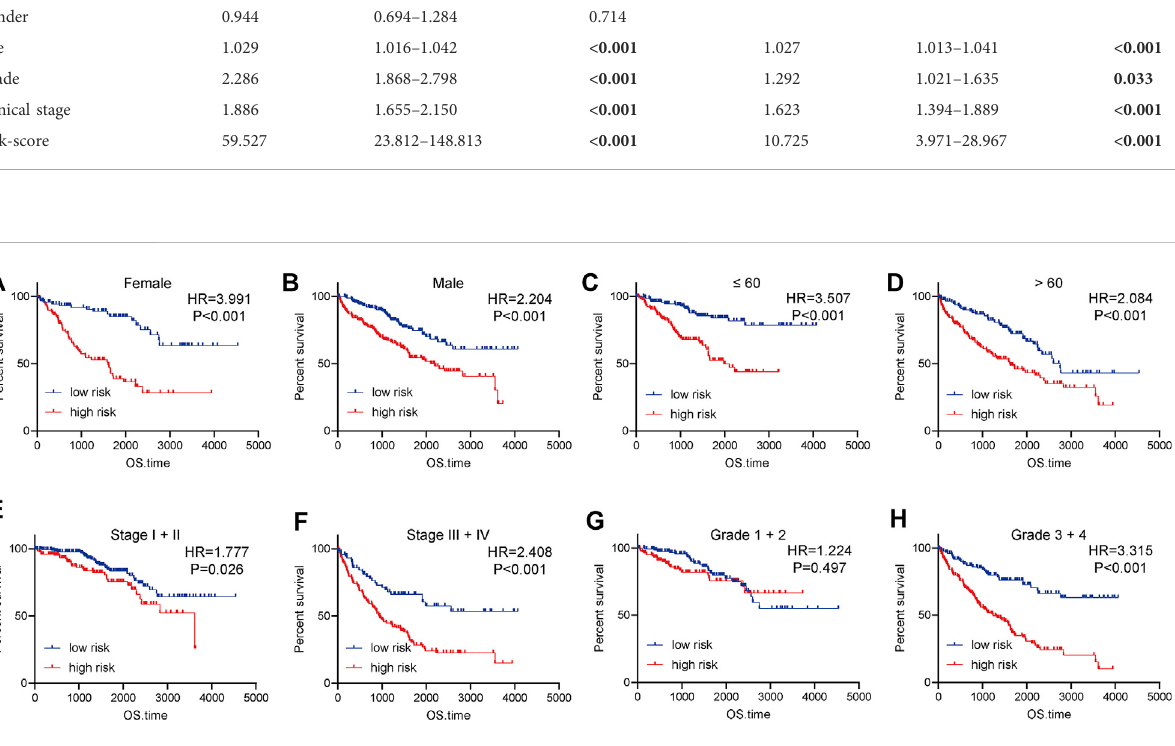
FIGURE 6 Subgroup analysis of the prognostic value of the risk score in ccRCC. (A,B) The prognostic value of the risk score in female and male patients. (C,D) The prognostic value of the risk score in patients with different ages. (E,F) The prognostic value of the risk score in patients at different clinical stages. (G,H) The prognostic value of the risk score in patients with various differentiated grades. Signi fi cance was calculated with log-rank